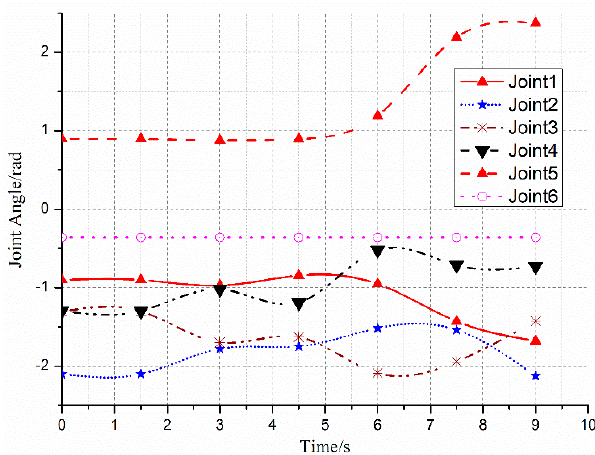
Figure 10. Variation of each joint angle during the process of dynamic obstacle avoidance.